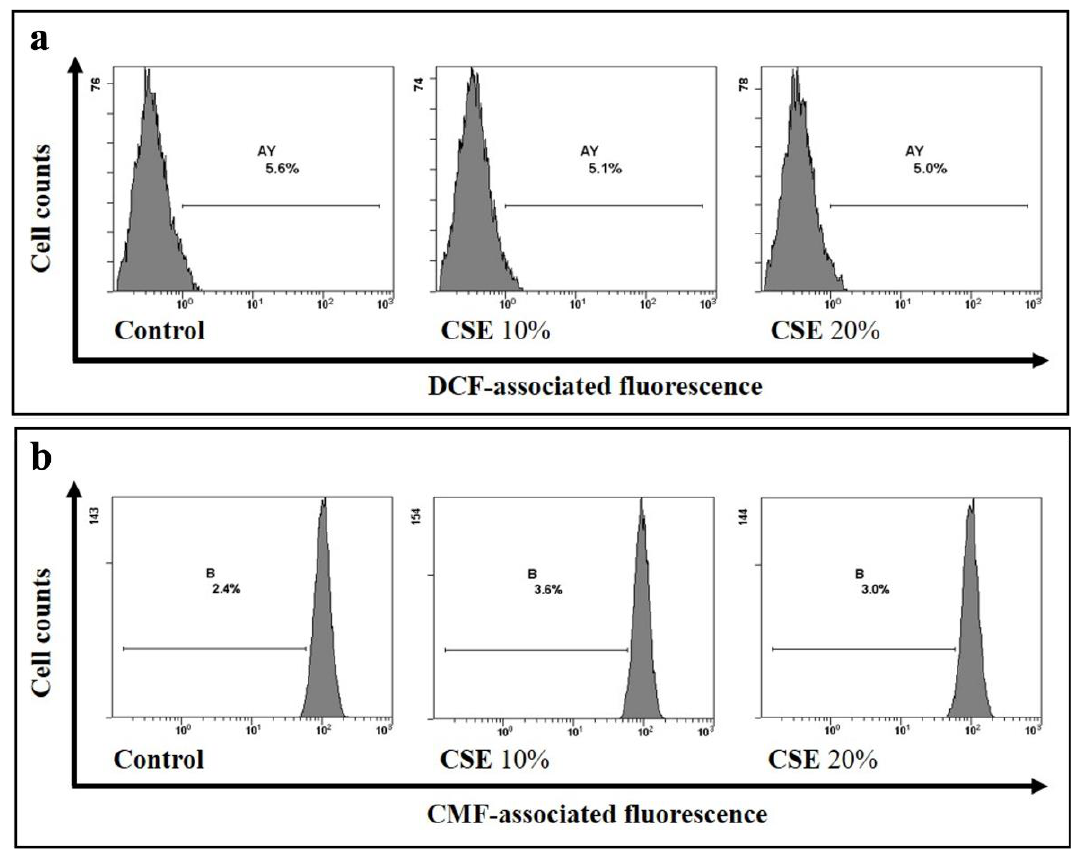
Figure 2. CSE does not induce oxidative stress in erythrocytes. ( a ) ROS levels and ( b ) GSH content in RBCs after 24 h incubation with CSE. RBCs incubated with vehicle were used as control. Representative images of four experiments carried out in triplicate with comparable results.